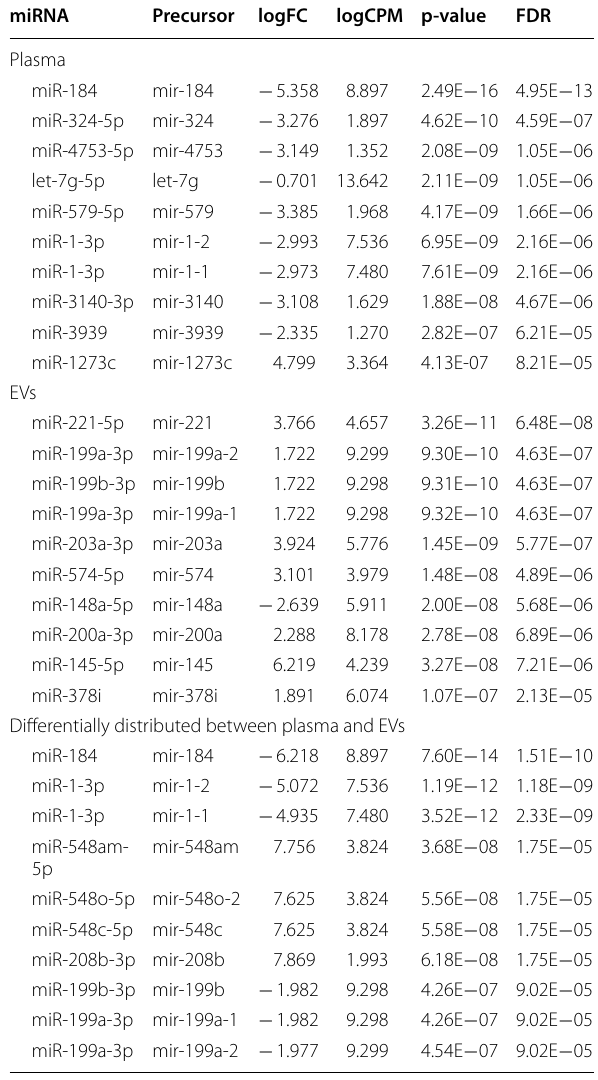
logFC log fold change, logCPM log counts per million, FDR false discovery rate